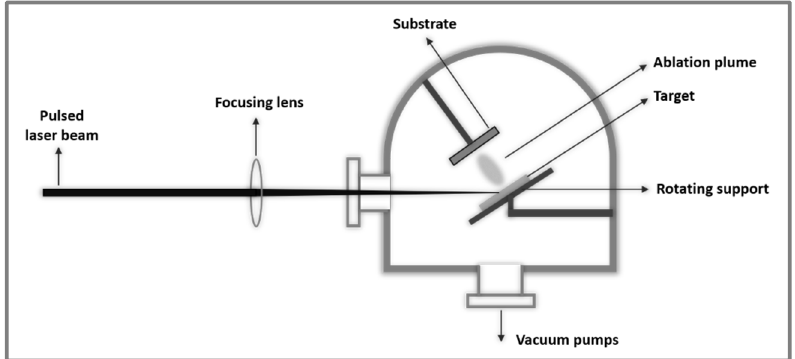
Figure 12. Diagram of PLD process.